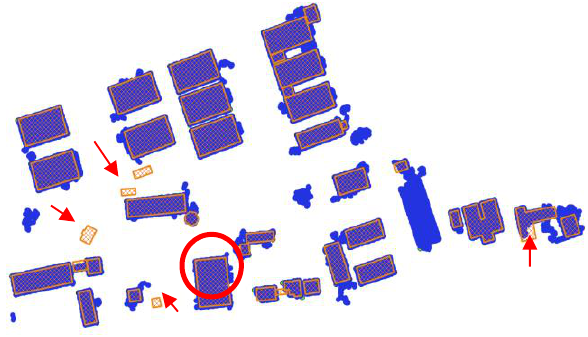
Figure 9. Base map (orange) and filtered building points (blue) Figure 10. presents the comparison of building roof lines from the base map and roof lines resulting from the proposed method.